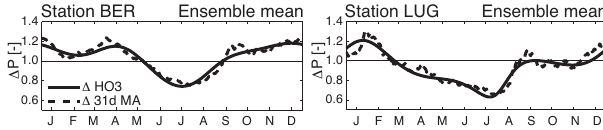
Fig. 7. Illustration of the overshooting problem for the example of the GCM-RCM DMI-ARPEGE-HIRHAM at the station LUG. Annual cycle of P in the CTL (top) and SCE 2070-2099 (middle) period as well as its climate change signal (bottom) estimated by use of different filters. The inset shows the response function of the spectral filters.